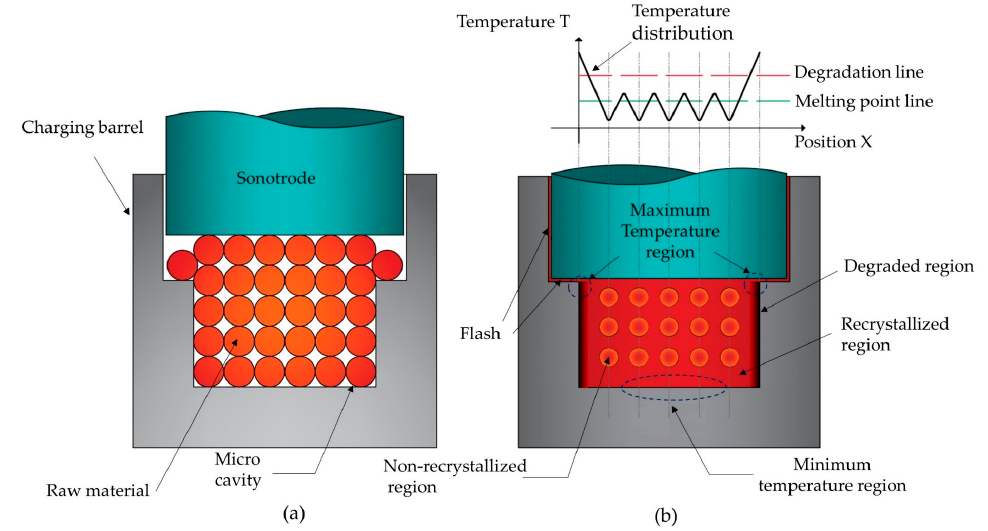
Figure 4. Temperature distribution in ultrasonic compression molding. ( a ) Before molding; ( b ) after molding. Adapted from Reference [13].